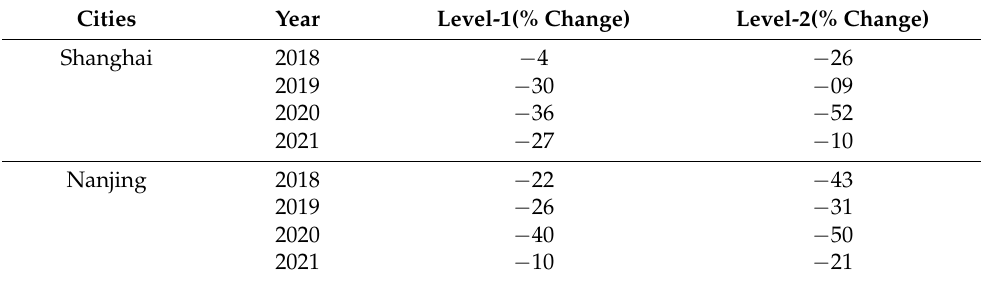
Table 3. Percentage change in mean PM 2.5 during lockdown levels (Level-1 (24 January–26 February), Level-2 (27 February–31 March)) with reference to Pre-lockdown Phase (1 January–23